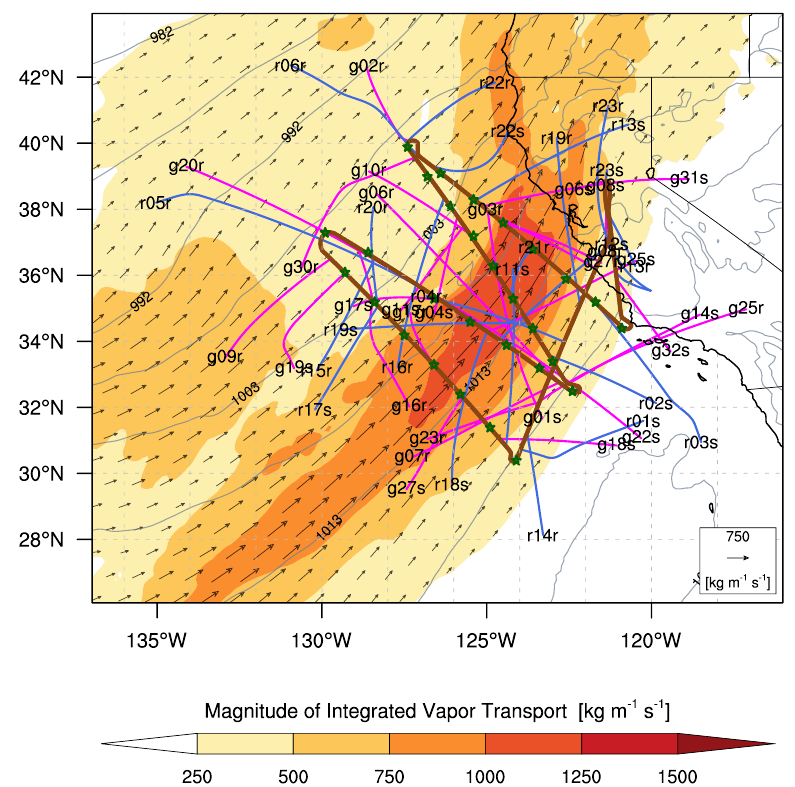
Figure 3. Same as Figure 2 but a close-up view centered over the flight path. Each occultation is labeled with the satellite identification number preceded by “g” for GPS and “r” for GLONASS and followed by an “r” for rising and “s” for